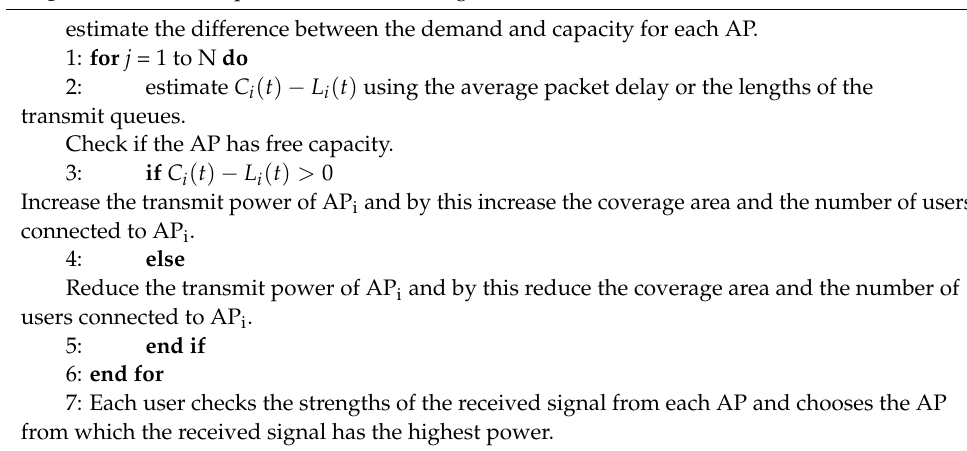
Algorithm 6 Non cooperative user clustering